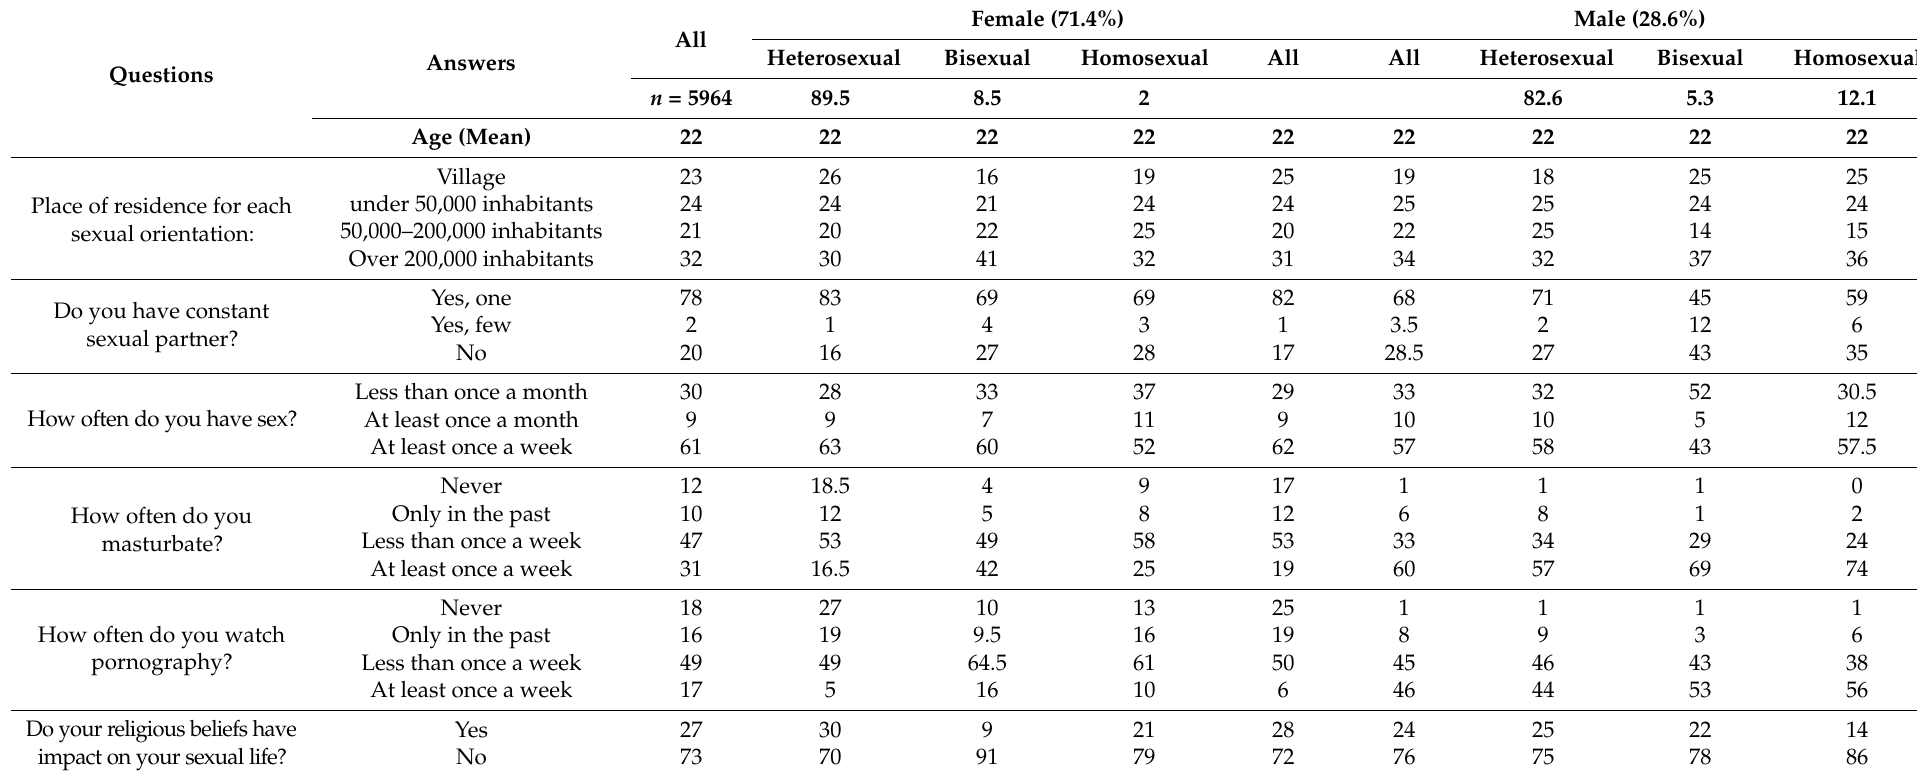
Table 1. Characterization of the study group. All data contained in the table are presented as a percentage.